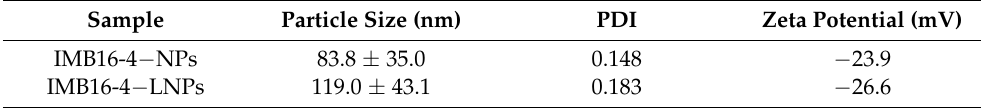
Table 1. The size, PDI, and Zeta potential of IMB16-4 − LNPs and IMB16-4 − NPs suspensions.